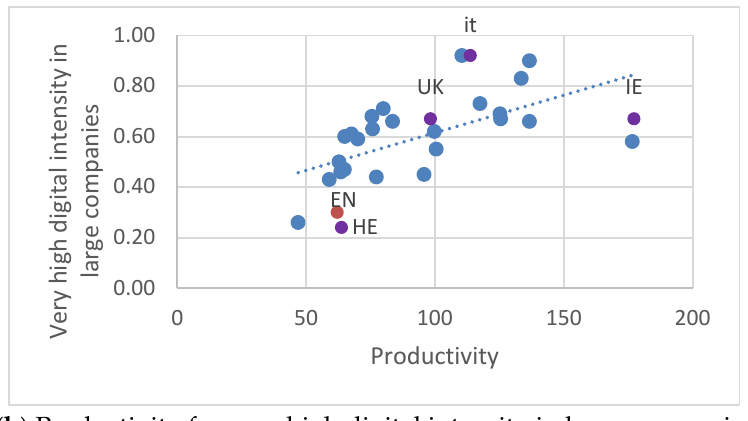
Figure 3. The relationship between digital intensity in large companies and the level of productivity. Source: Processing based on data provided by Eurostat [16].